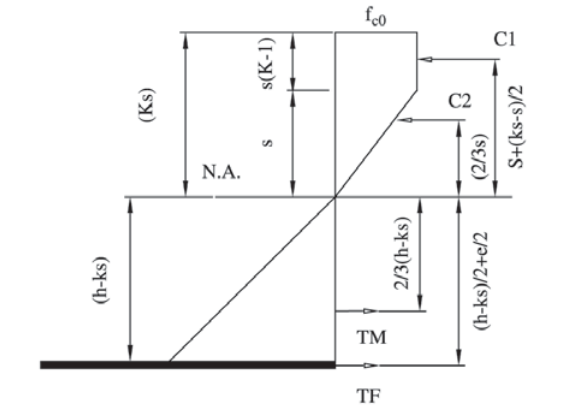
Figure 9. Distribution of stresses in the transversal section (fail- ure by compression).